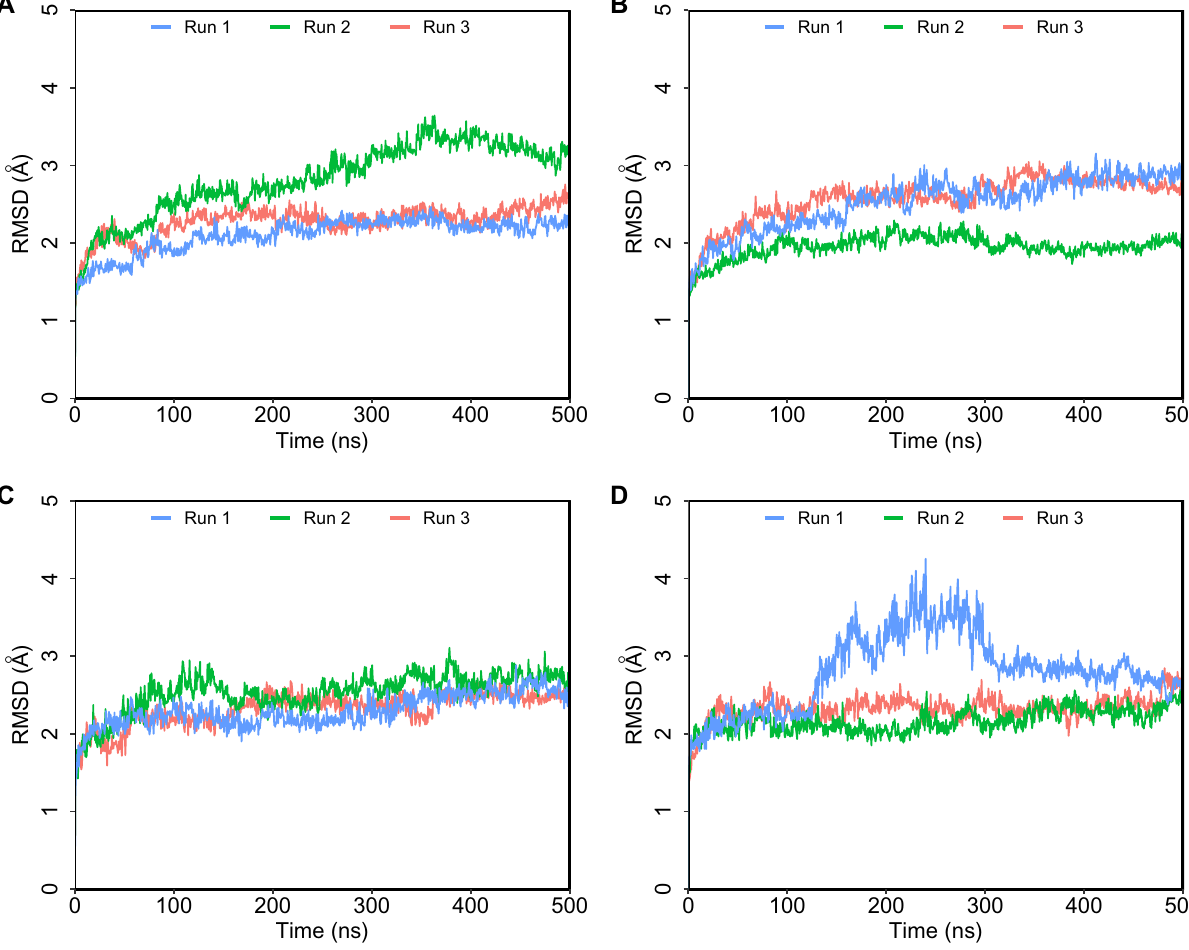
Figure 3. Root mean square standard deviation (RMSD) of protein Cα atoms obtained from 500 ns simulations. ( A ) Camel LVVHem6 with ACE1 ( B ) LVVHem6 with ACE1 ( C ) Camel LVVHem6 with ACE2 ( D ) LVVHem6 with